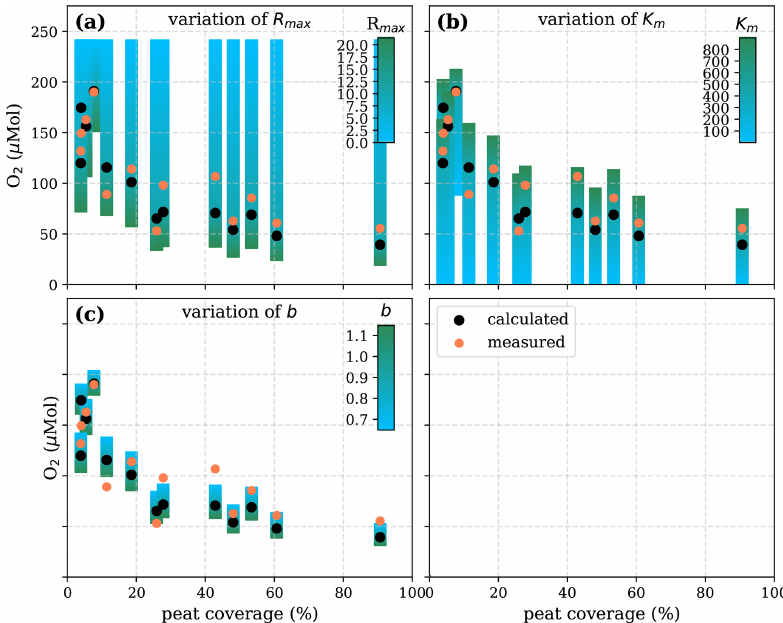
Figure A6. Sensitivity of calculated O 2 to (a) the maximum decomposition rate ( R max ), (b) the Michaelis constant for O 2 concentration ( K m ), and (c) the fraction of O 2 consumption by decomposition ( b ) according to the equation in Table 1 for the linear pH approach and the parameter ranges given in Table